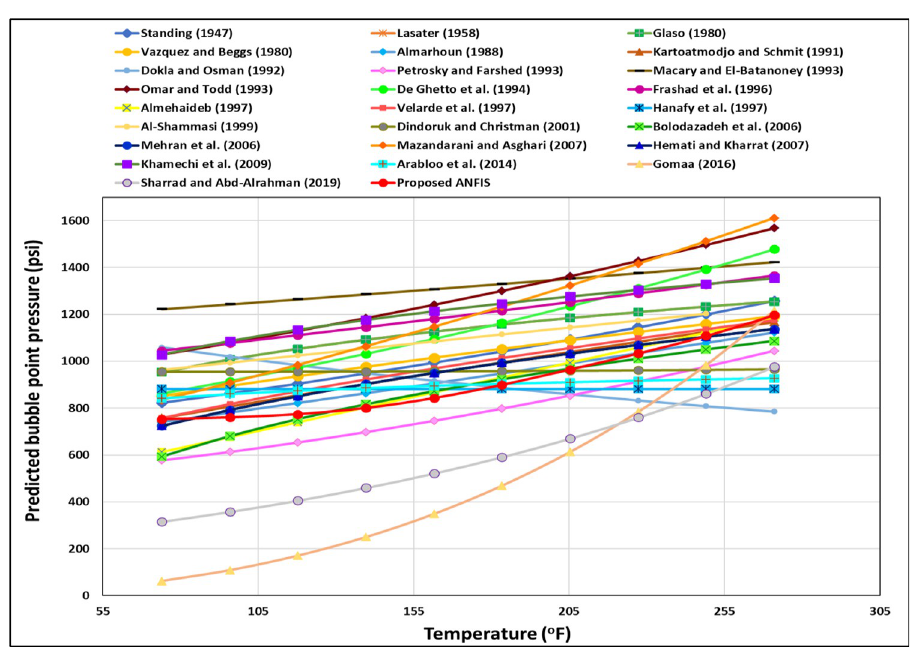
Fig 11. T TrA of the ANFIS and existing models. f